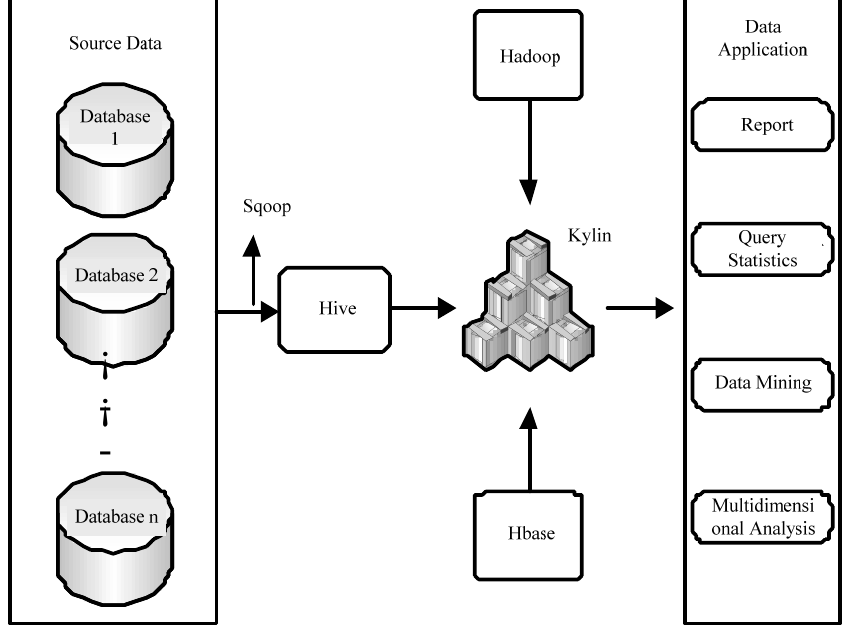
Figure 2. Big data platform environment construction.